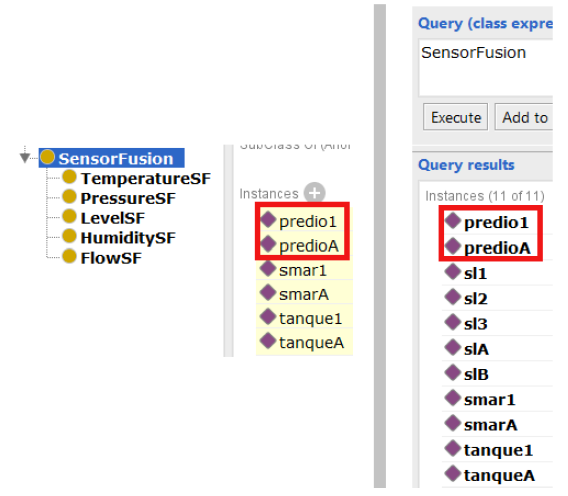
Figure 14. The left side of the figure shows resources, production lines and, inside of the red square, areas in fusion. The right side of the figure shows the Description Logic (DL) Query with all the elements that are in fusion, including